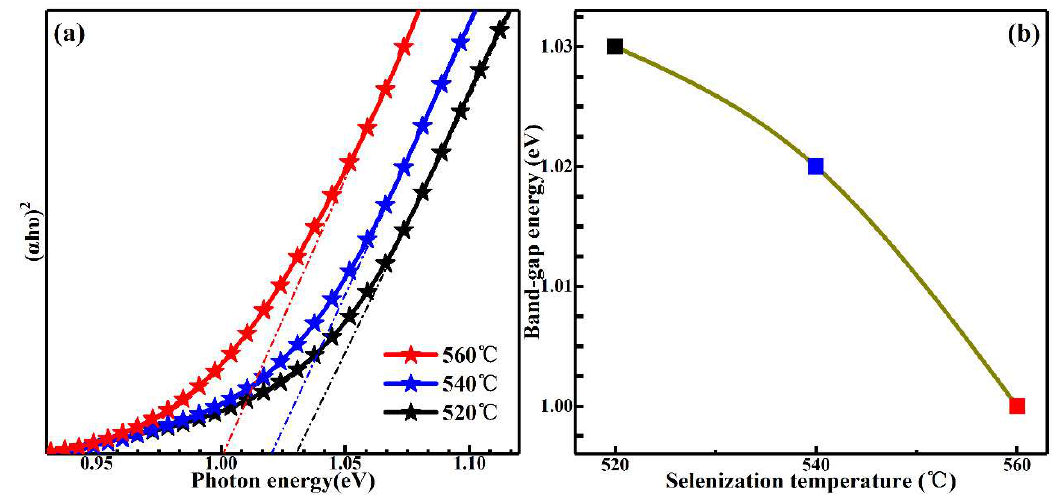
Figure 6. ( a ) The plot of ( α h υ ) 2 vs. h υ for the absorption spectra; ( b ) band gap variation as a function of the selenization temperature.